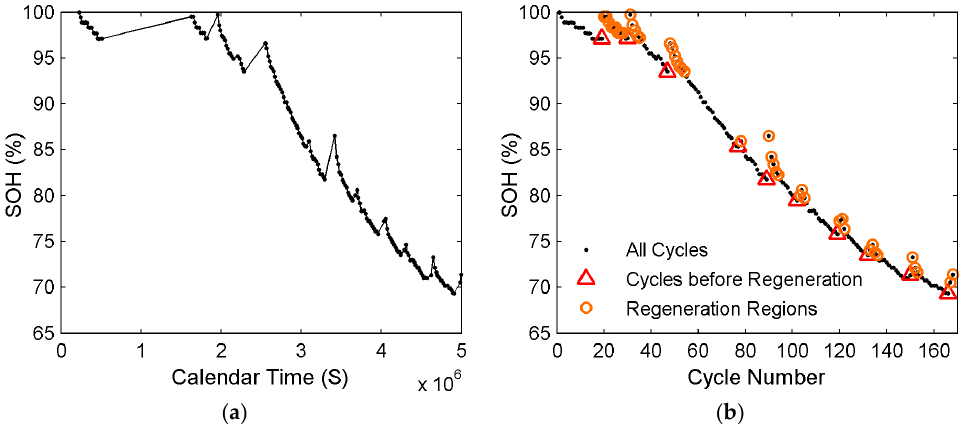
Figure 3. The experimental degradation data: ( a ) with calendar time; and ( b ) with cycle